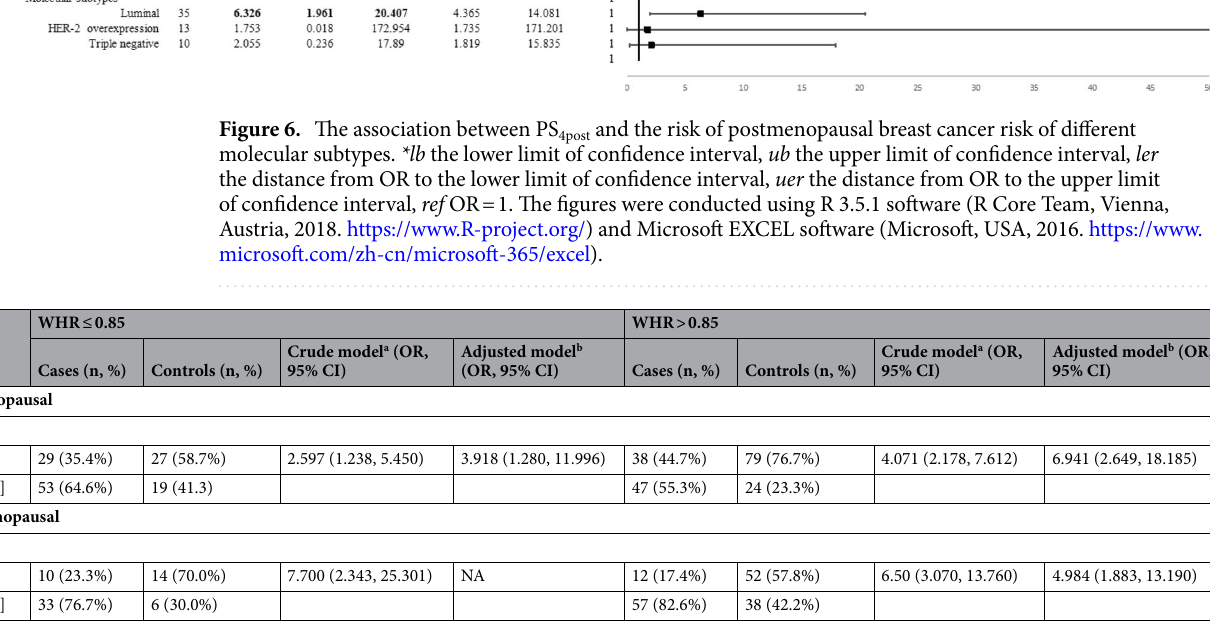
Table 4. The association between PS 5pre , PS 4post and the risk in different WHR. a Crude model: only the score, without other environmental risk factors. b Adjusting age at menarche, residence, education, income, occupation, adverse pregnancy history, abortion history, energy intake and exercise in adjusted model of PS 5pre. Adjusting residence, education, income, occupation, passive smoking, adverse pregnancy history, abortion history, energy intake and estrogen disease in adjusted model of PS